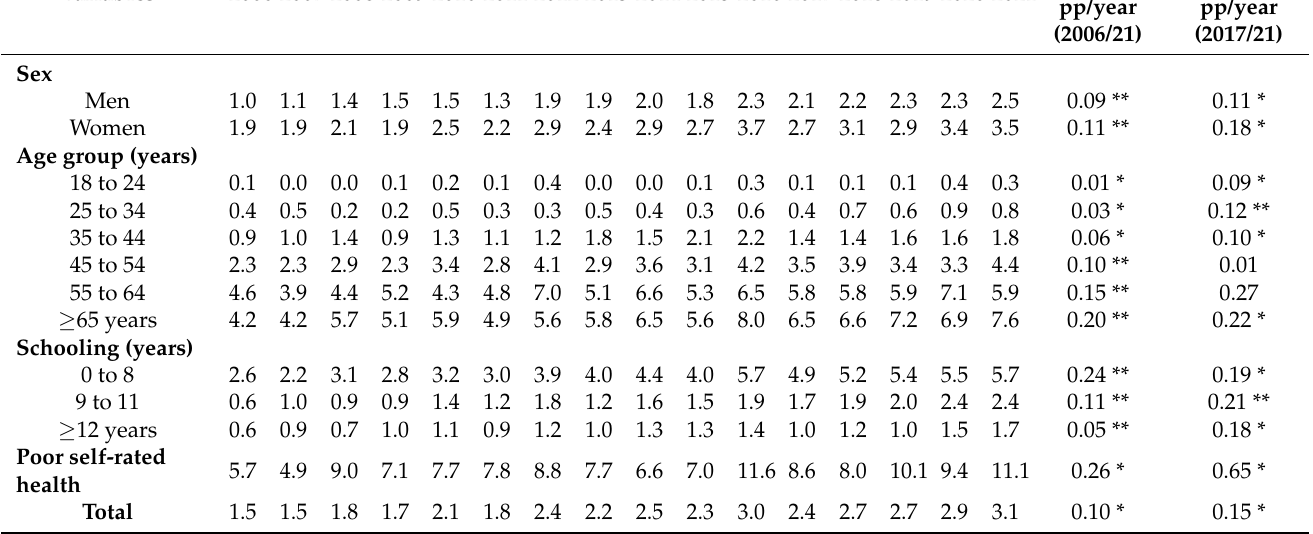
Table 2. Prevalence (%) of co-occurrence of obesity and diabetes among Brazilian adults ( ≥ 18 years), by year, according to sociodemographic characteristics and self-rated health. Vigitel Brazil,